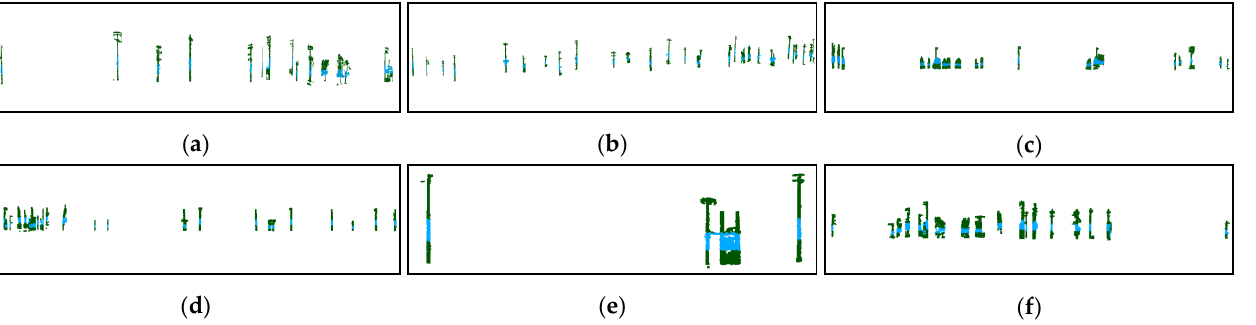
Figure 11. Location results of candidate telegraph poles. ( a ) Dataset-I. ( b ) Dataset-II. ( c ) Dataset-III. ( d ) Dataset-IV. ( e ) Dataset-V. ( f ) Dataset-VI. (3) Telegraph pole location